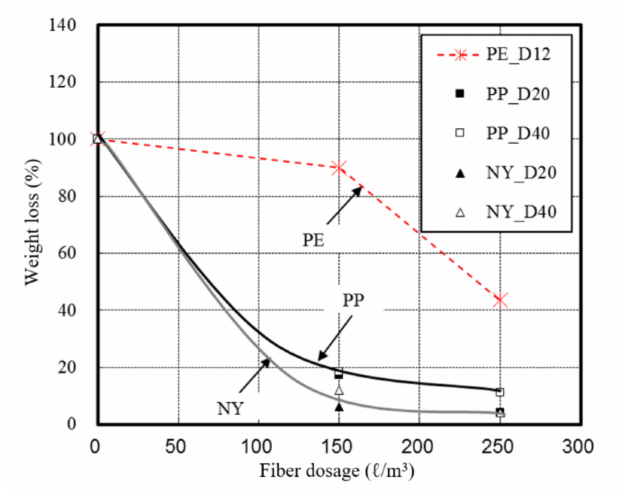
Figure 8. Weight loss of concrete where spalling occurs for di ff erent